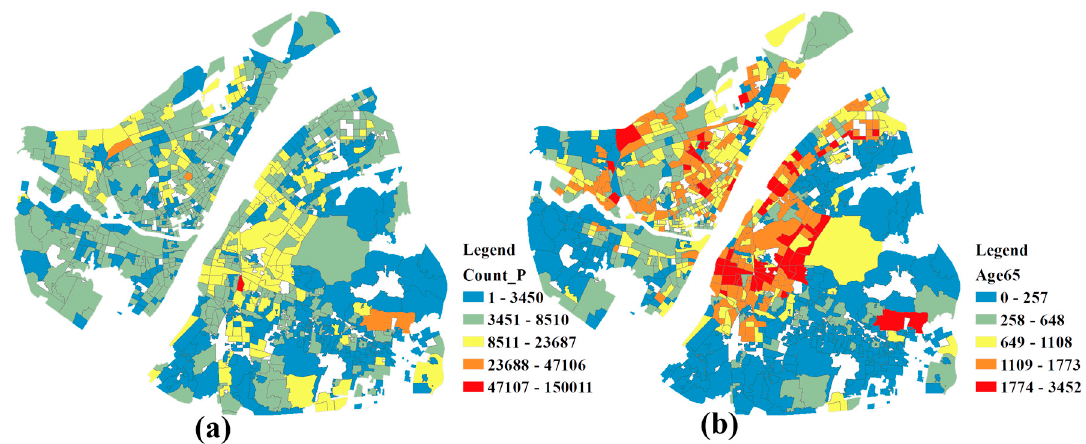
Figure 3. ( a ) The population distribution map; ( b ) the elderly distribution map.